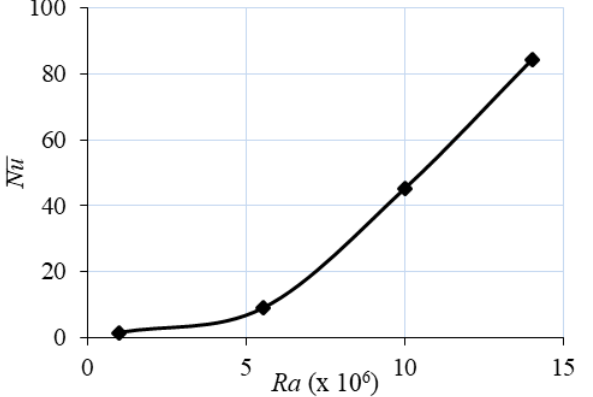
Fig. 12. Mean Nusselt number of the hot basewall against Rayleigh number for 15 o -roof pitch